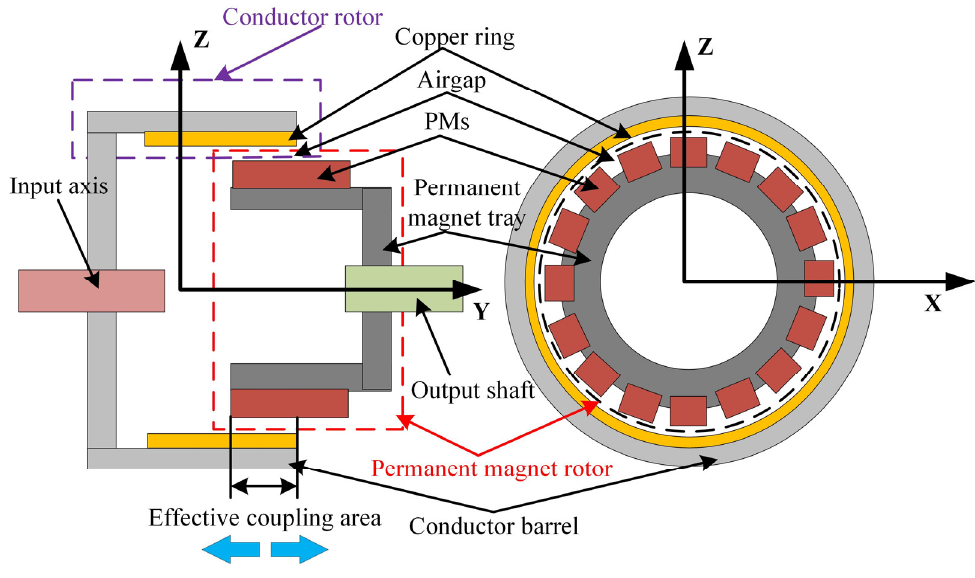
Figure 1. Structure of CPMG.